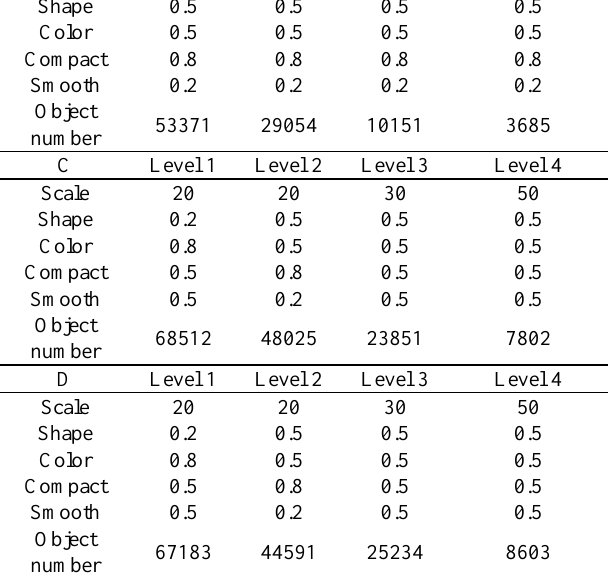
Figure 3. Different spatial resolution images